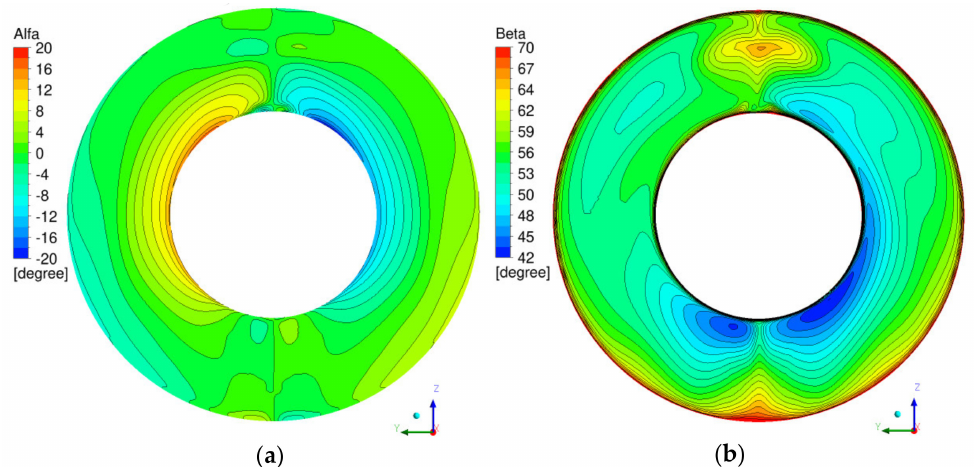
Figure 7. Whirl angle variation 1 axial chord upstream of the rotor leading edge. ( a ) Stationary frame; ( b ) in the rela- tive